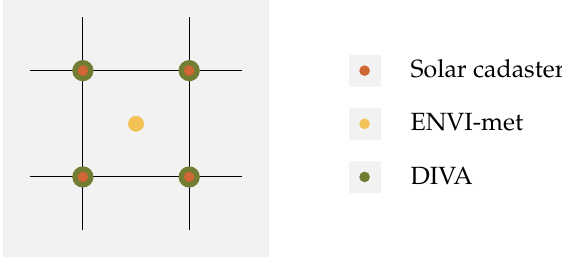
Figure 4. Differences in terms of irradiance calculations for a